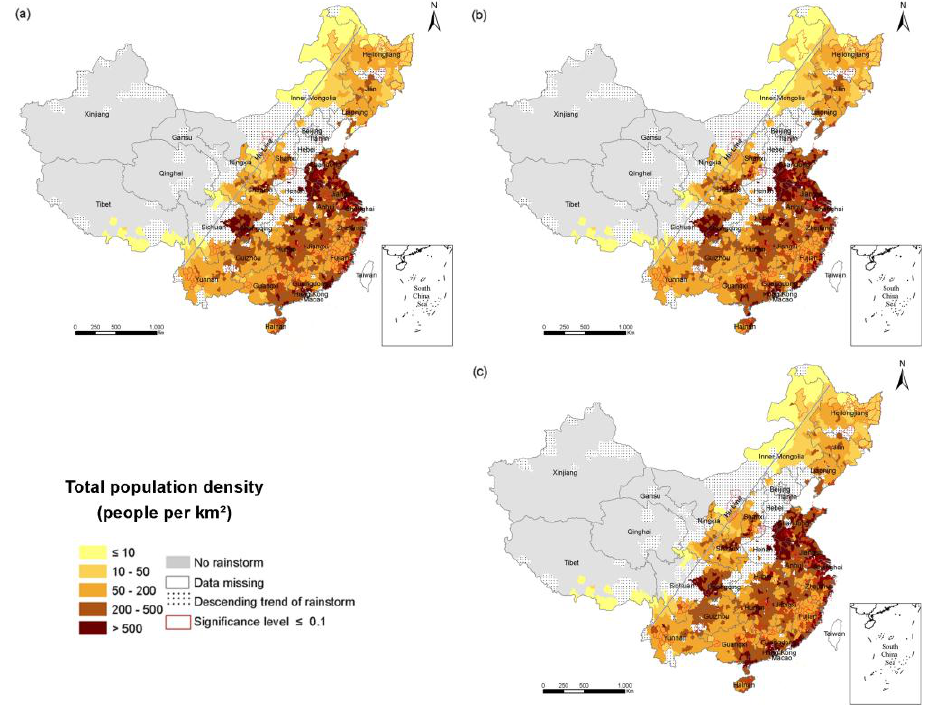
Figure 3. The density of the total population in the RSHA. ( a ) 1990; ( b ) 2000; ( c ) 2010;